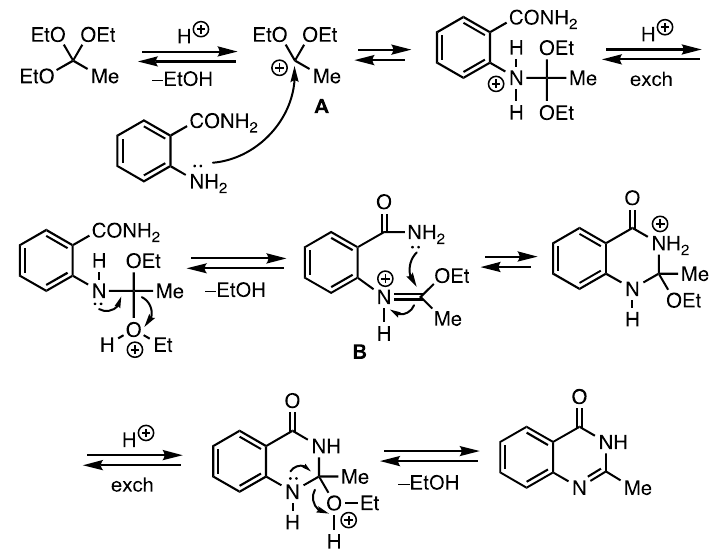
Figure 2. Mechanism for quinazolin-4(3 H )-one formation.